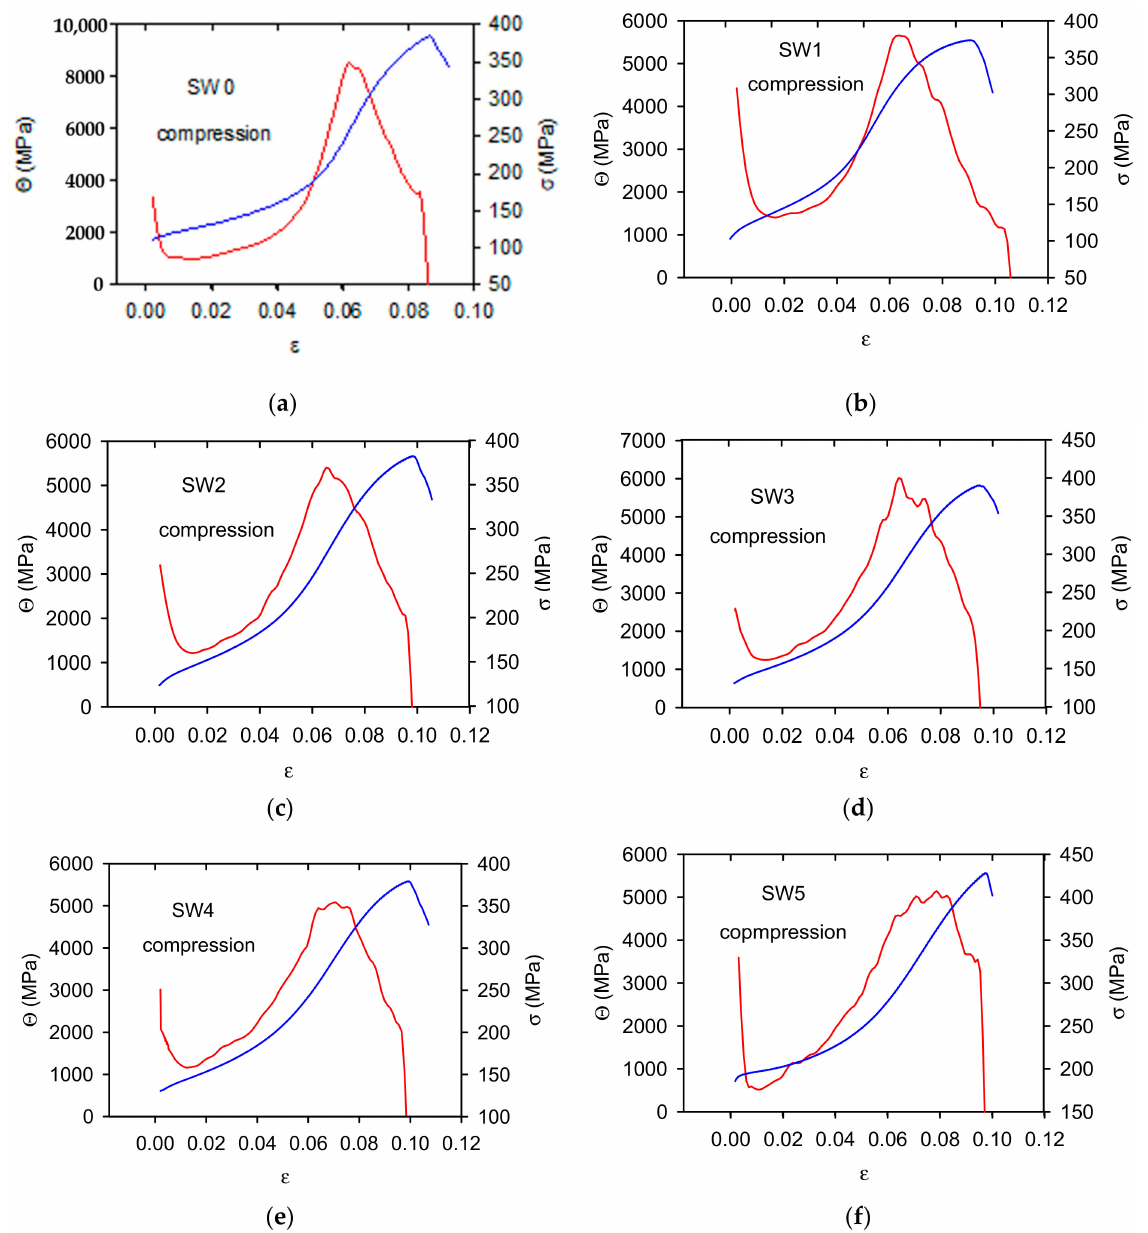
Figure 6. Strain dependence of the work hardening coefficients calculated for the curves obtained in compression: ( a ) SW0, ( b ) SW1, ( c ) SW2, ( d ) SW3, ( e ) SW4 and ( f ) SW5. σ - ε curves are drawn in the blue colour and Θ - ε curves in